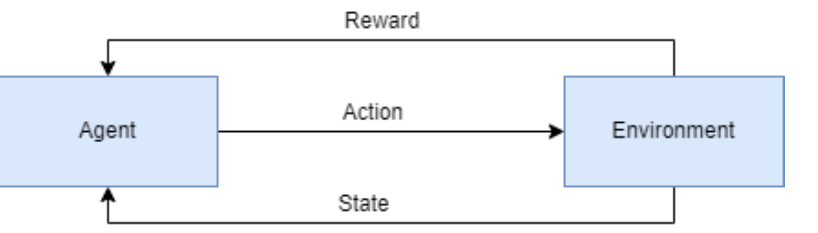
Figure 2. Reinforcement learning description